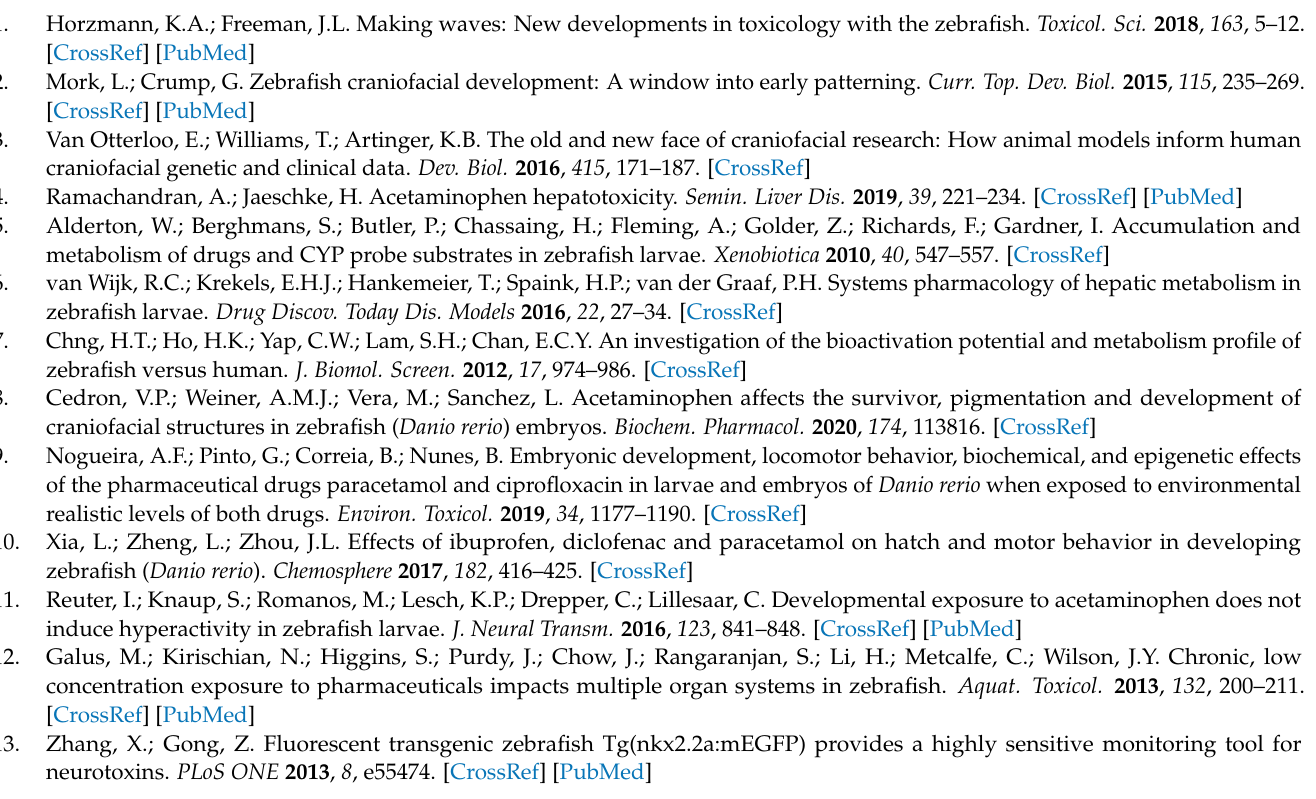
responses; Figure S3: APAP treatment results in lower heart rates; Figure S4: APAP-treated embryos have a widespread increase in